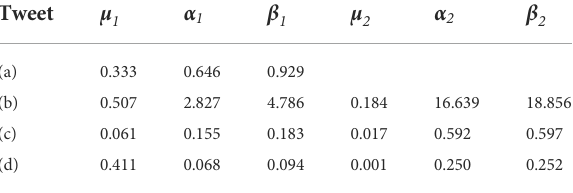
TABLE 2 Parameter estimation for the four